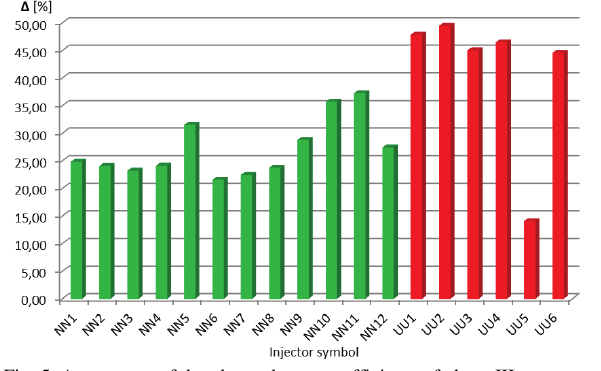
Table 2. Average values of the duration of each phase in the fuel injection signal. Δ is the coefficient of variation of the parameter under investigation